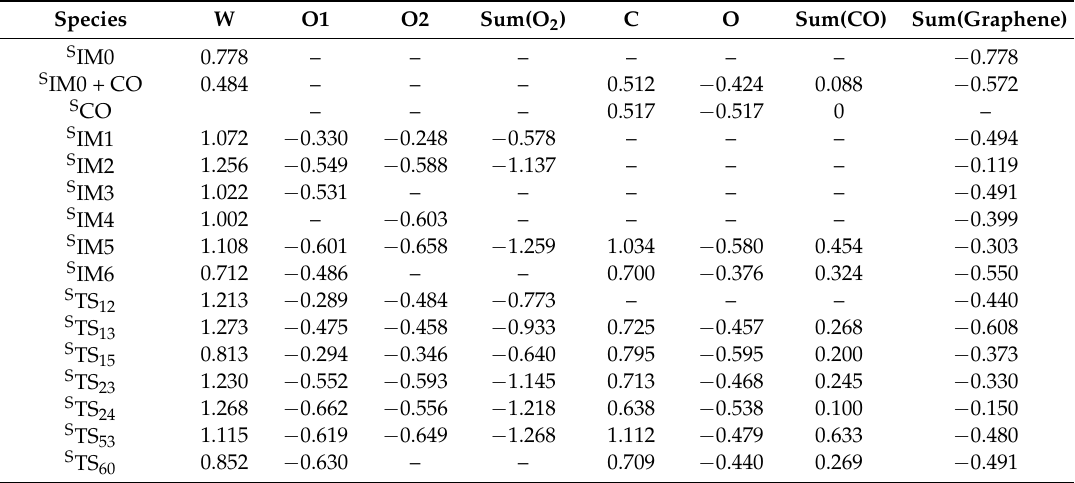
Figure 4. Electron density difference (EDD) between the oxygen and ( a ) W-SV-graphene; ( b ) W-DV-graphene (The electron density accumulation and depletion sites are displayed in solid and dashed lines, respectively). Table 1. Calculated NBO charge of different species over